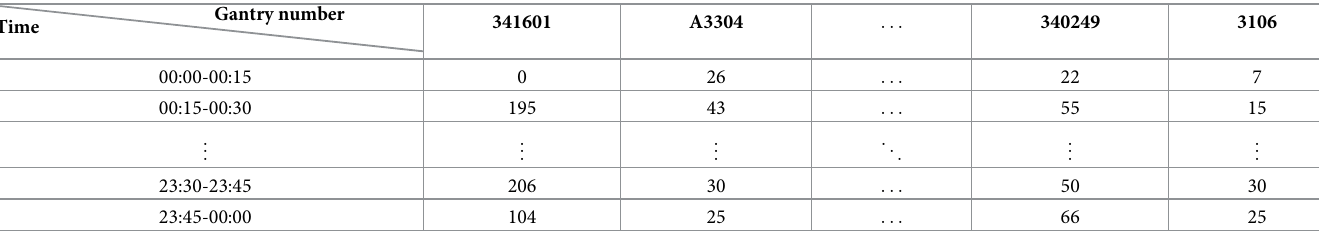
Table 3. Flow statistics table for each gantry and toll